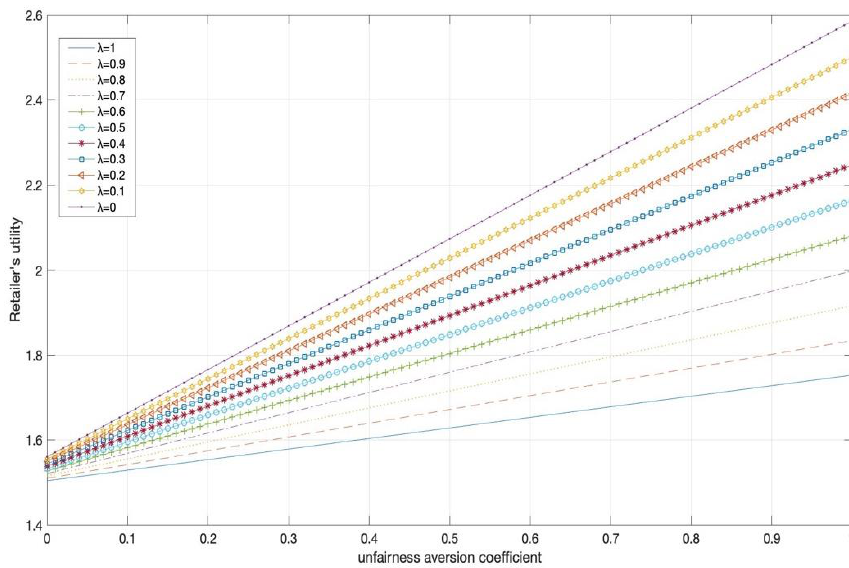
Figure 6. The effect of different distribution proportion on the retailer utility.